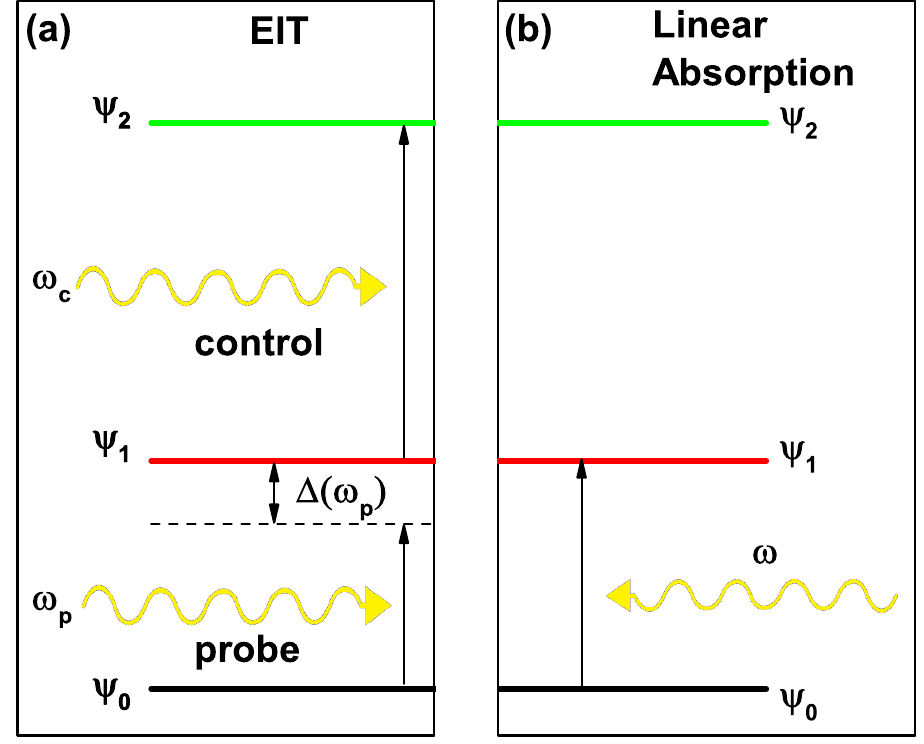
Figure 4. ( a ) diagram of a three-level system ( Ψ 0 , Ψ 1 , Ψ 2 ) in a cascade arrangement, interacting with two electromagnetic fields of frequencies ω c and ω p (control and probe, respectively). ( b ) diagram of the absorption of a photon of frequency ω between states Ψ 0 and Ψ 1